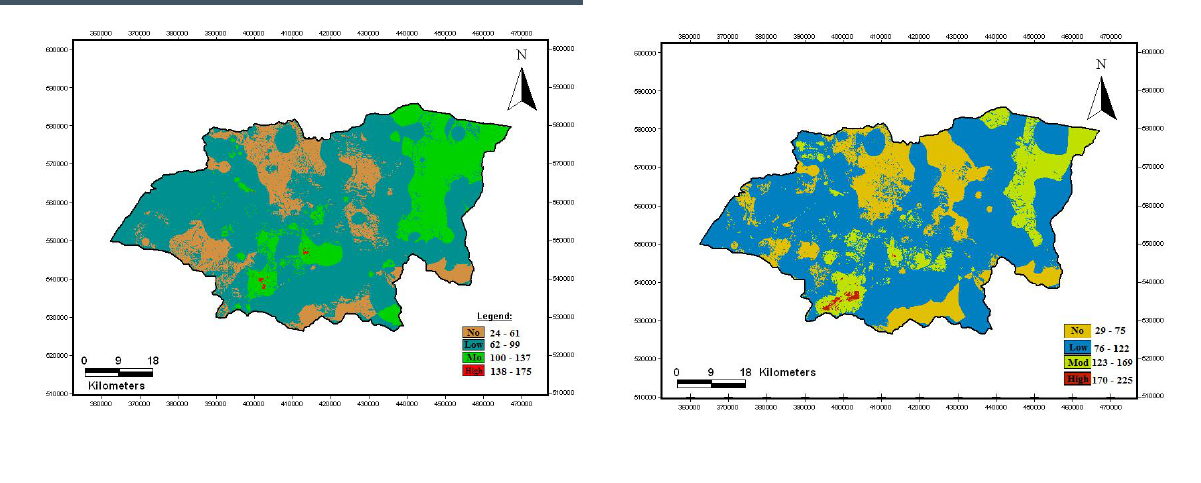
Figure 10. Generic DRASTIC vulnerability map classes of groundwater.